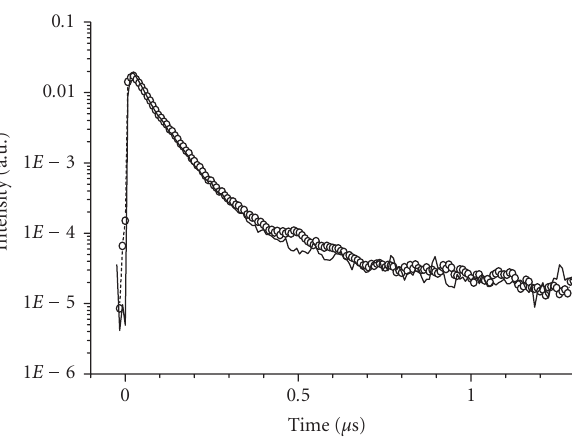
Figure 3: Experimental (solid line) and simulated (circles) emission decay curves at RT of Ce-doped SG (Ce : Si = 1 · 10 − 3 molar ratio) inverted opals ( λ exc = 290nm; λ em = 415